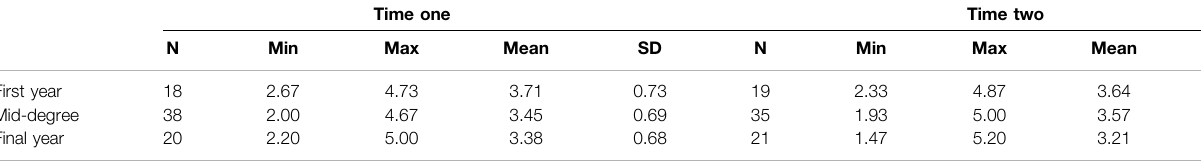
TABLE 6 | MAAS scores Summary Time One and Time Two .